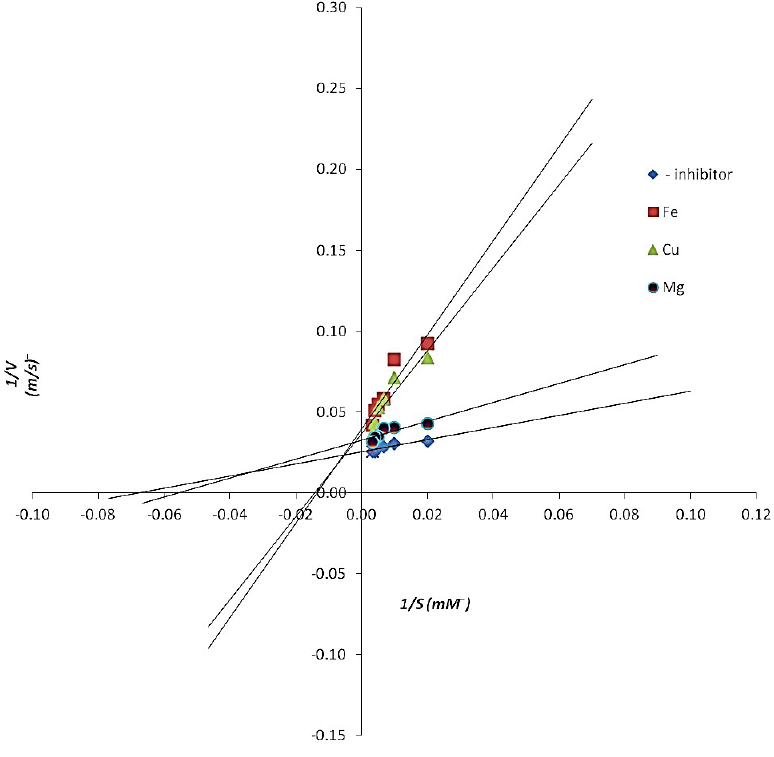
Figure 10: Double reciprocal plot for C. lanatus rind invertase activity in the presence of Fe 2+ , Cu 2+ , Mg 2+ and Zn 2+